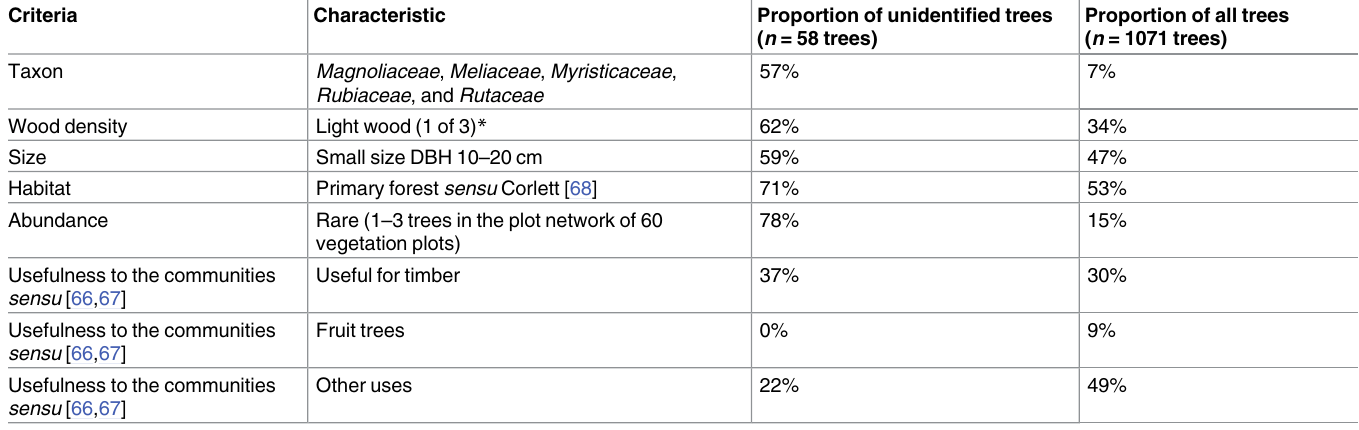
Table 3. Characteristics of trees unidentified by community monitors compared to total number of trees in montane forests in Yunnan, China. * Light wood was classified by community monitors on a scale from 1 to 3 (low to high wood density).